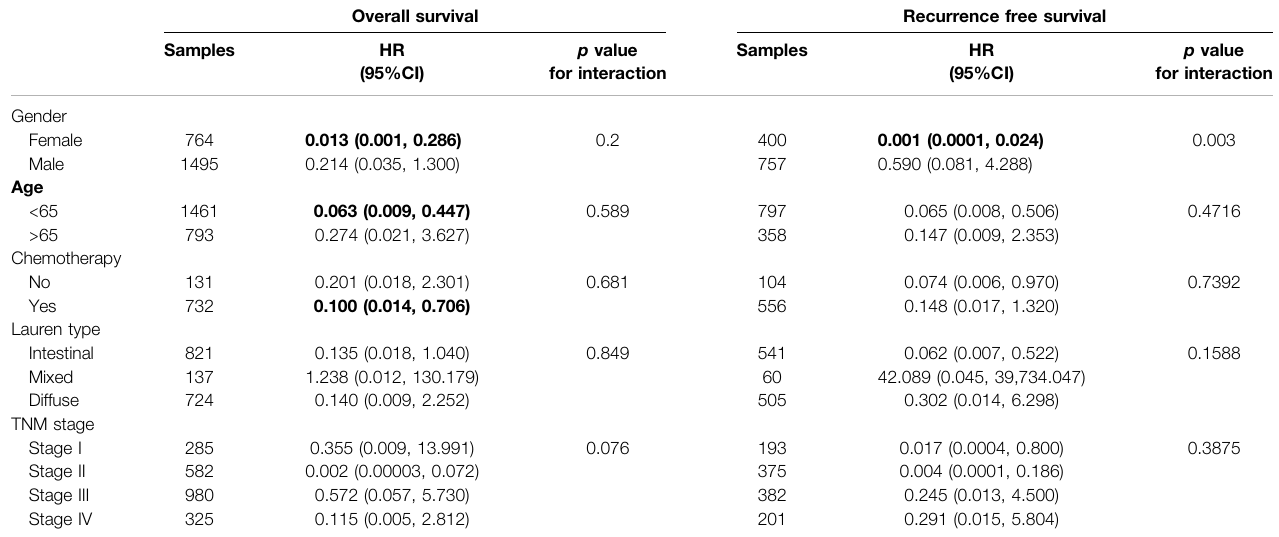
TABLE 3 | Subgroup analysis for tumor purity in gastric